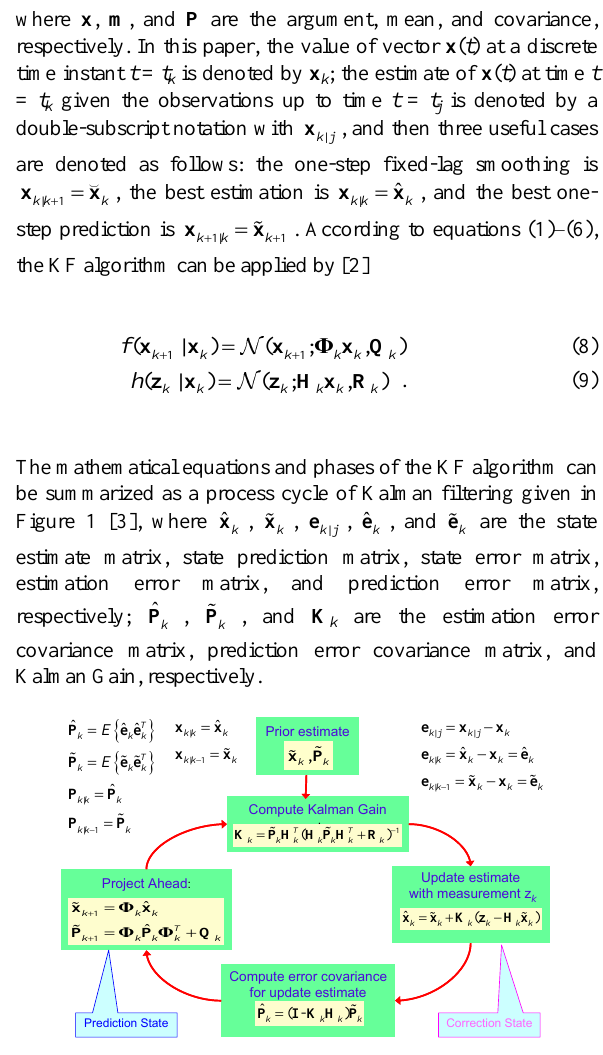
Figure 1. The process cycle of Kalman